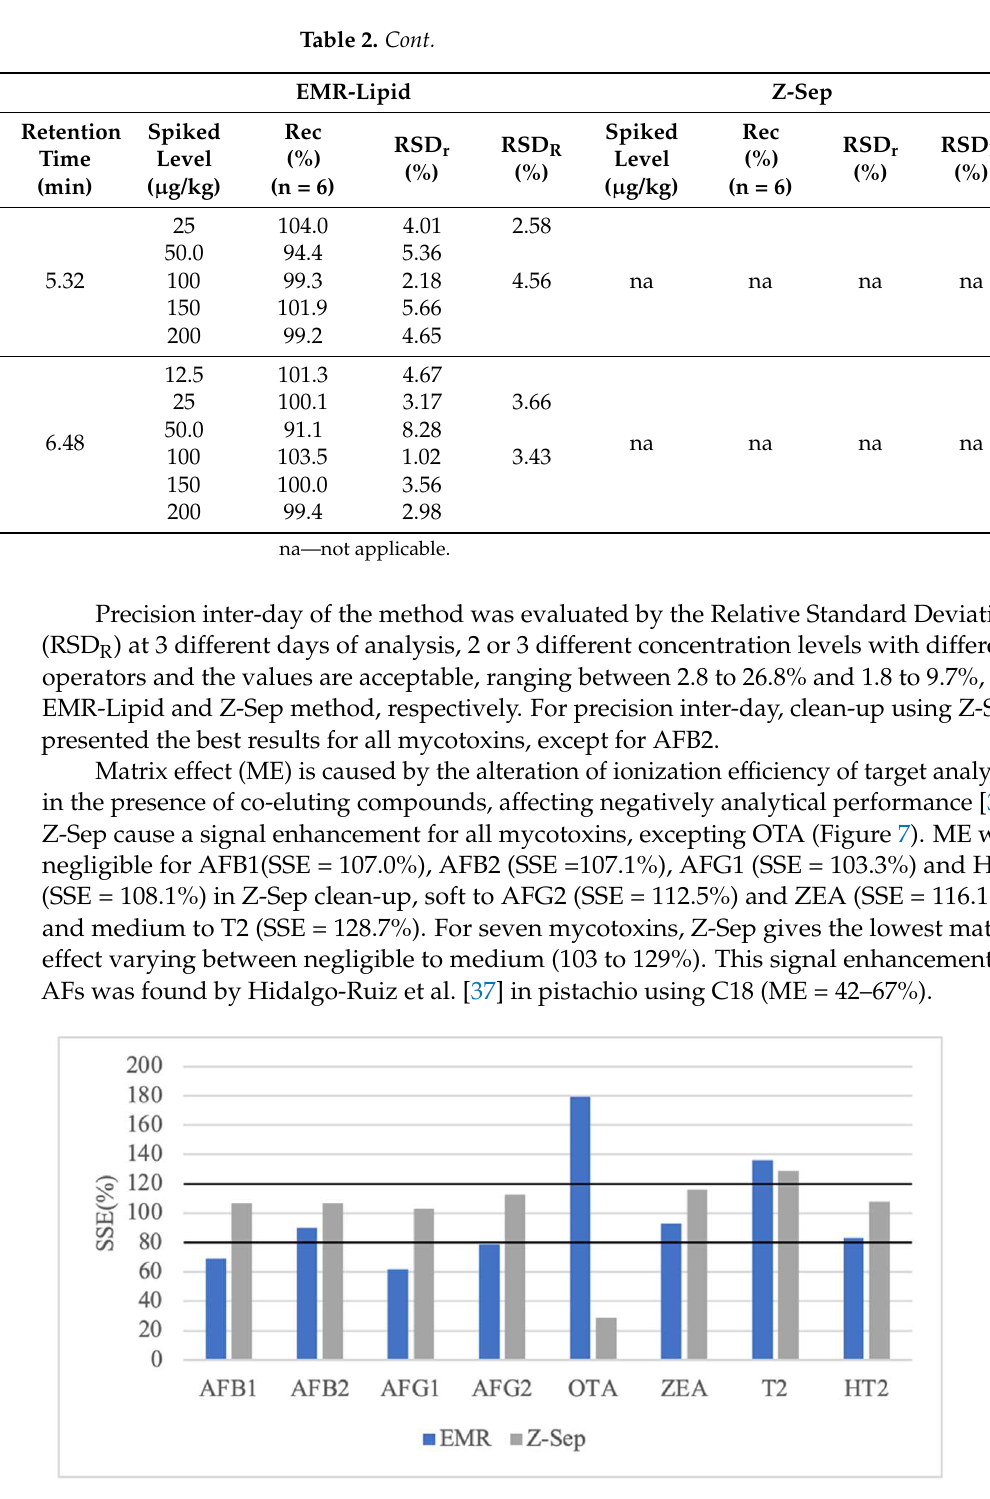
Figure 7. Matrix effect with enhanced matrix removal-lipid (EMR-lipid) and zirconium oxide (Z-Sep) as dispersive solid- phase extraction (d-SPE) sorbents for ten